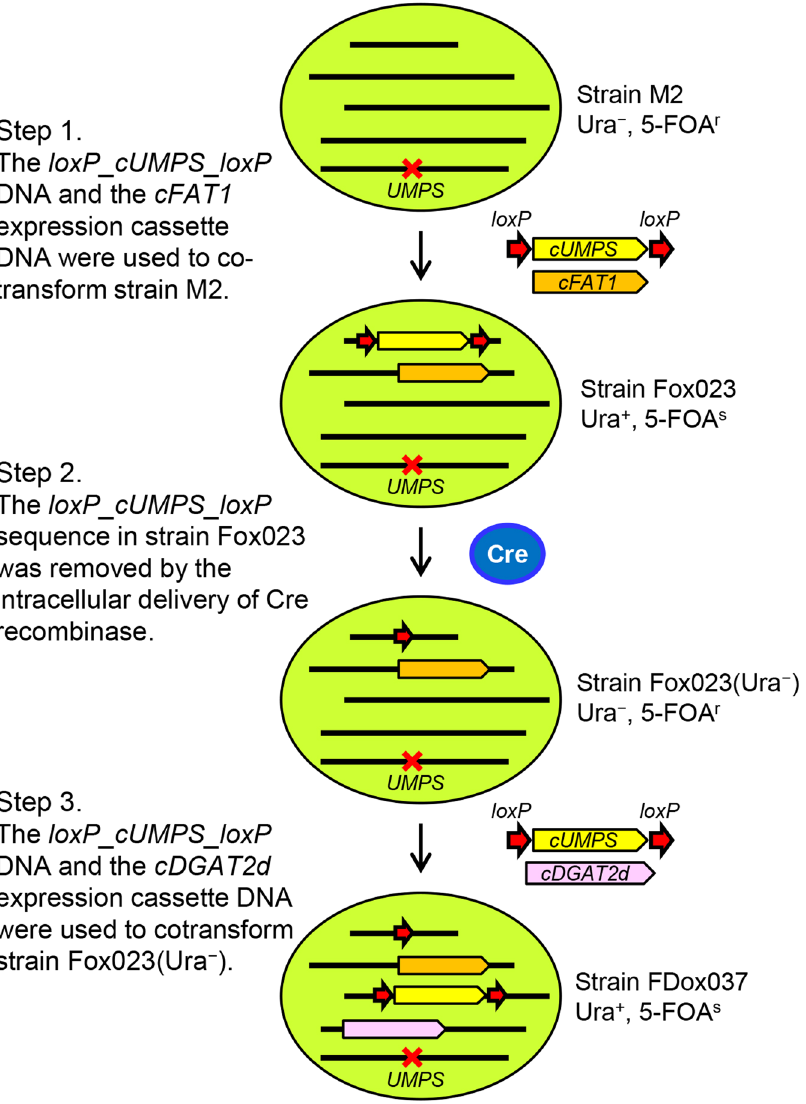
Figure 1. Three steps for the construction of self-cloning Coccomyxa overexpressing cFAT1 and cDGAT2d . Step 1. The loxP_cUMPS_loxP DNA and the cFAT1 expression cassette DNA were used to co-transform strain M2. Ura + transformants, which carry a single copy of the loxP_cUMPS_loxP sequence and the intact cFAT1 expression cassette sequence, were selected. Among the selected transformants, strain Fox023 exhibited the highest lipid productivity. Step 2. Purified Cre recombinase protein was introduced in cells of strain Fox023, and clones cured of the loxP_cUMPS_loxP sequence were identified among FOA r derivatives. One of such clones named strain Fox023(Ura − ) was used in step 3. Step 3. The loxP_cUMPS_loxP DNA and the cDGAT2d expression cassette DNA were introduced in strain Fox023(Ura − ), and Ura + transformants, which carry a single copy of the loxP_cUMPS_loxP sequence and the intact cDGAT2d expression cassette sequence, were selected. Among the selected transformants, strain FDox037 exhibited the highest lipid